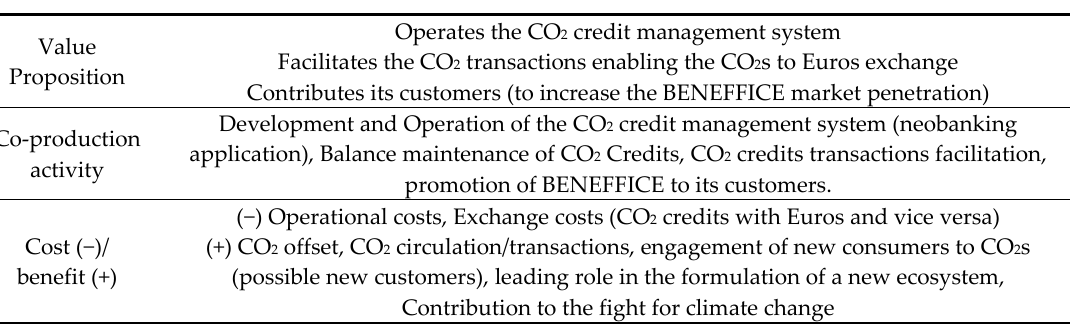
Table 7. CO 2 credit management system.